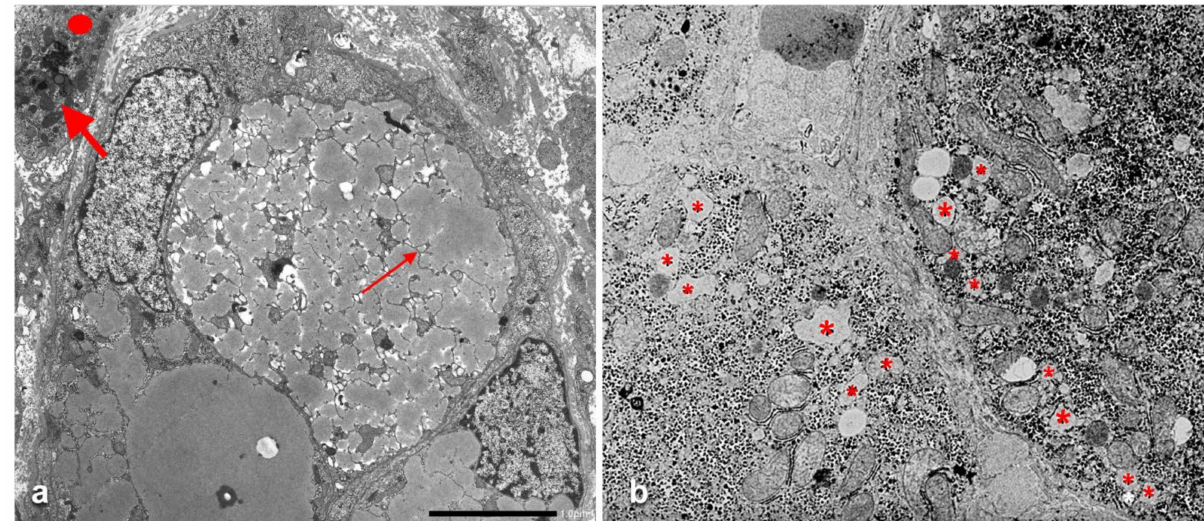
Figure 10. Pi MZ patient. The electronmicrophotograph shows dilated channels of the RER filling up the entire cytoplasm ( a ) EM × 14.500. Dilated channels coalesce in larger cisternae (arrow). This feature corresponds to type I immunohistochemical positivity. The electronmicrophotograph shows mildly dilated cisternae of the RER (*), located at the periphery of the cytoplasm of two adjacent hepatocytes, representative of type II positivity in immunostaining ( b ) EM ×